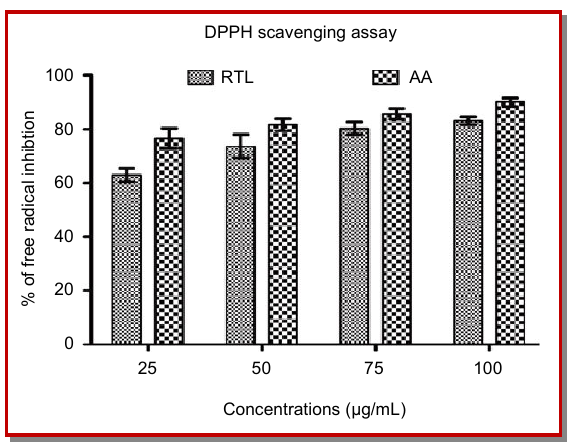
Figure 3: DPPH free radical scavenging activity of resorcinol type lipid isolated from C. cupreum Note: RTL- Resorcinol Type Lipid; AA- Ascorbic